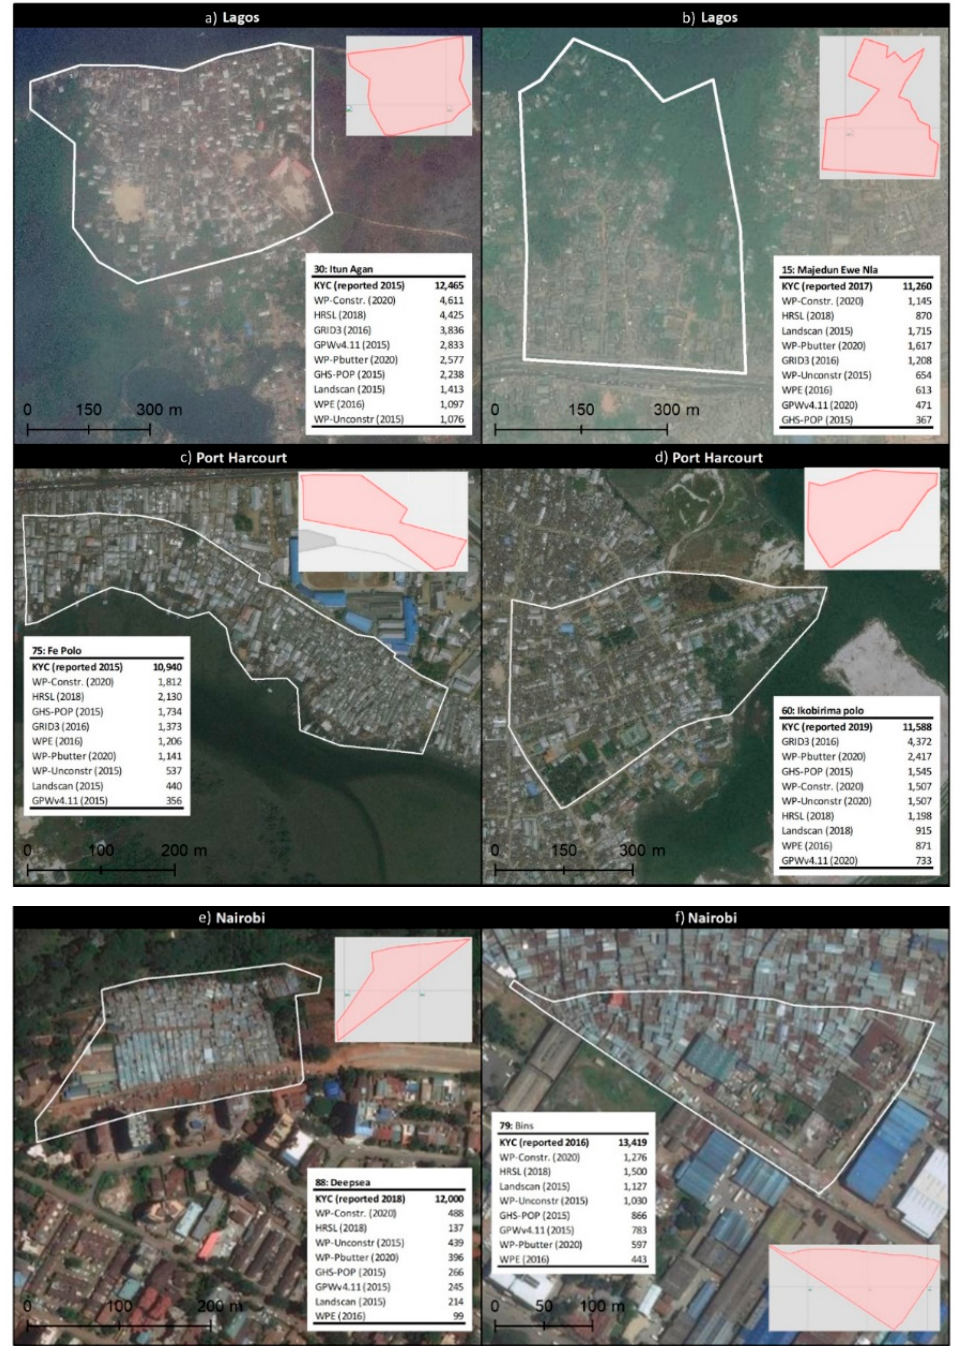
Figure A5. Comparison of gridded population estimates and KYC reported population in select settlements with severe gridded population underestimates for ( a , b ) Lagos, ( c , d ) Port Harcourt, and